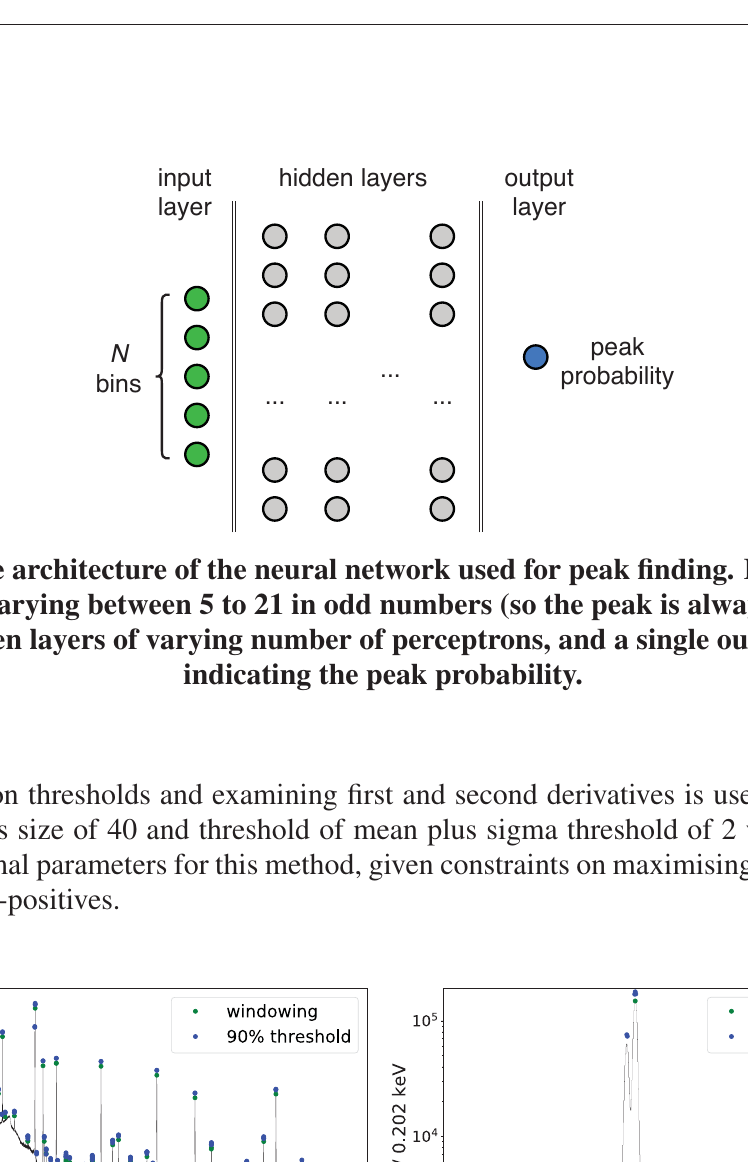
shifted vertically for visualisation purposes only, to avoid overlapping of points. Left shows full energy range, with the right showing a shorter energy range to highlight the duplet near 843